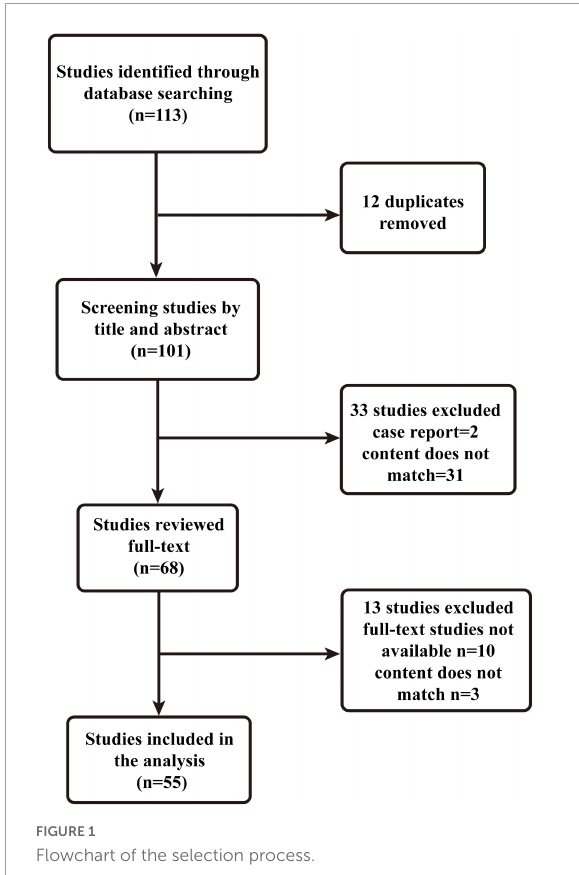
FIGURE1 Flowchart of the selection